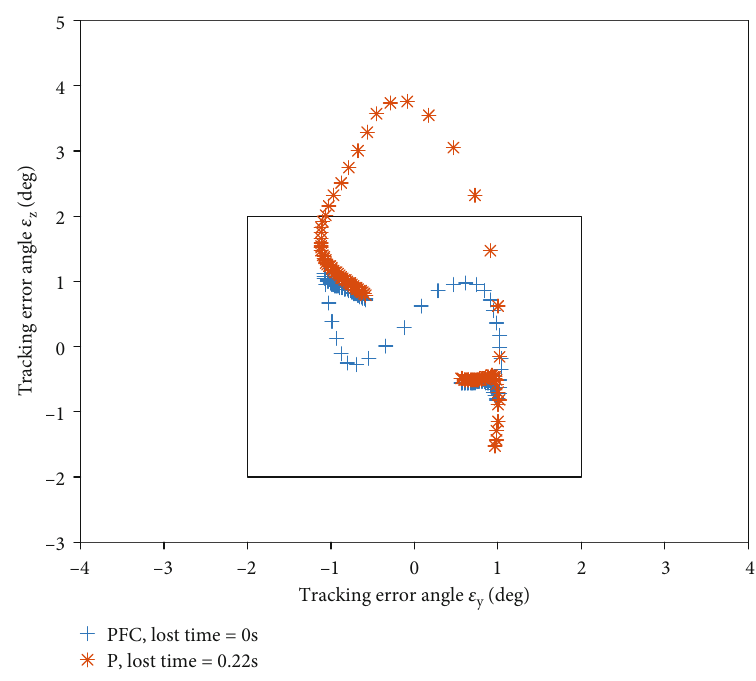
Figure 10: Tracking errors of PFC and PI (5 deg, 60deg/s).